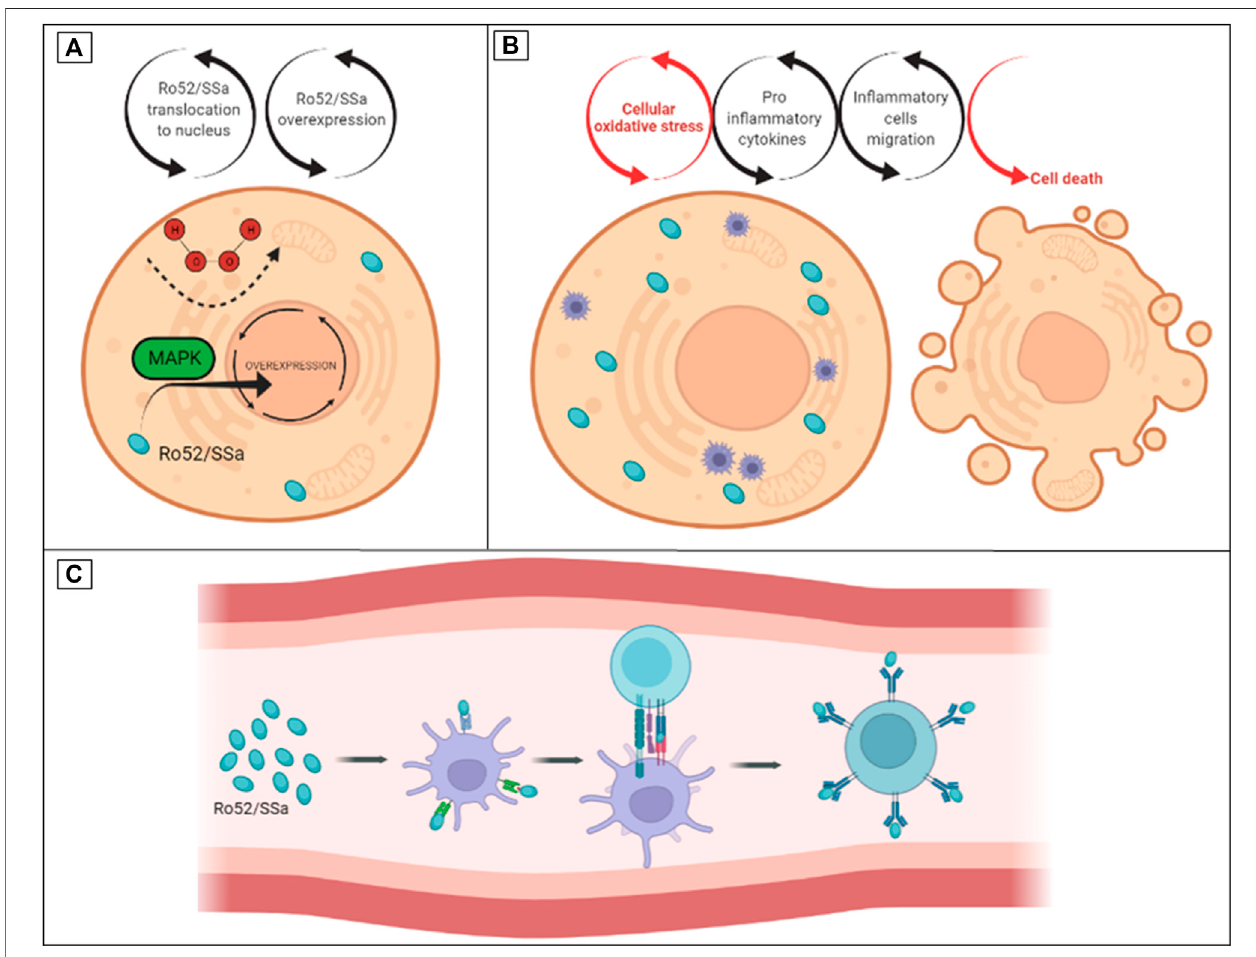
FIGURE2| ThehypothesisofturningRo52/SSafromanoxidativestressintracellularsignalingmoleculetoanautoantigeninSS. (A) Ro52/SSatranslocationtothe nucleus by H 2 O 2 stimuli. (B) Overexpression of Ro52/SSa led to cytotoxicity and in fl ammation. (C) Immune sensitization and production of anti-Ro autoantibodies.